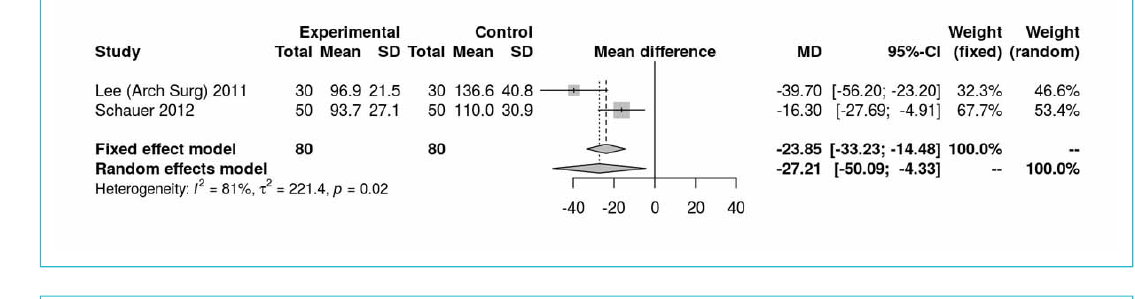
Figure S6k: Low-density lipoprotein at 36 months (analysis of studies including only patients with type 2 diabetes).